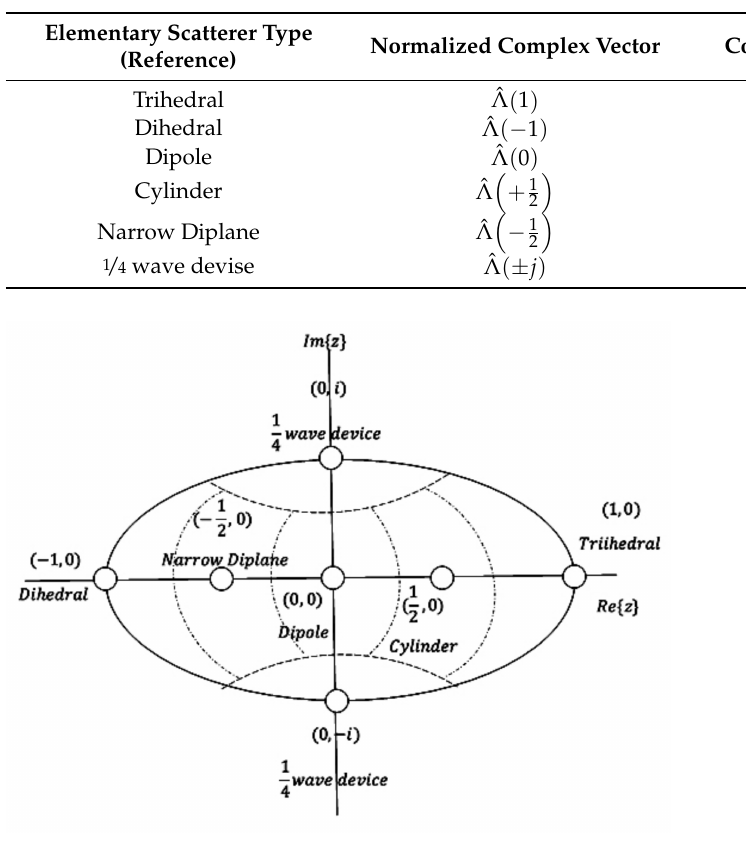
Figure 1. The position of the various types of elementary scattering mechanisms on Cameron’s Unit Disk